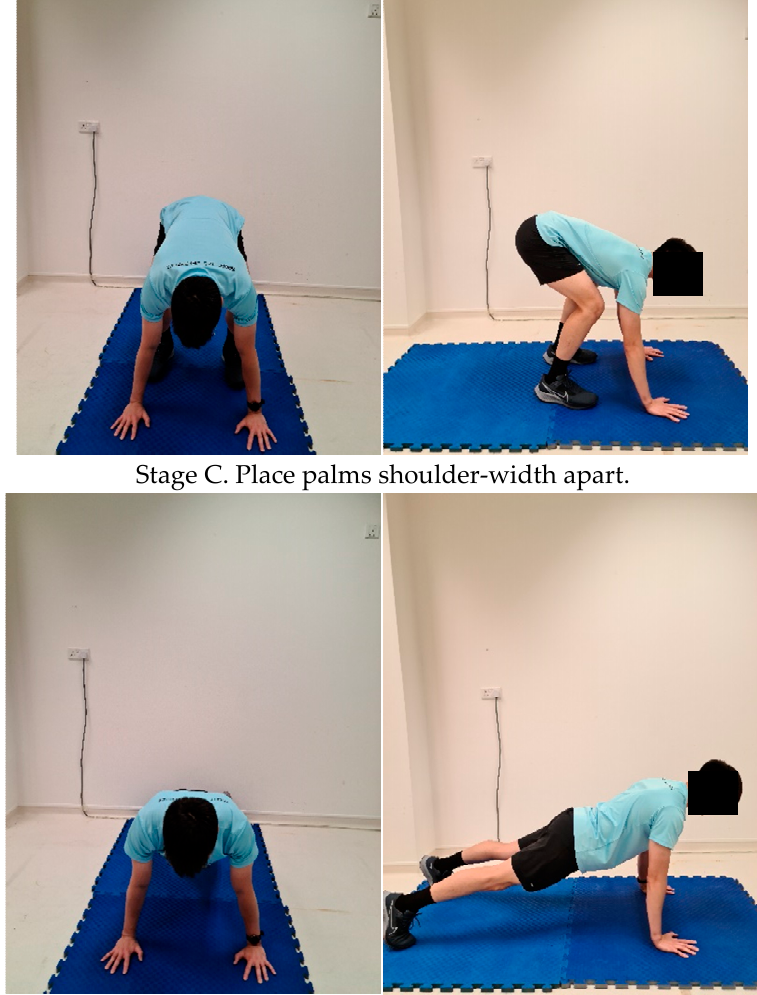
Stage D. Legs thrust backwards fully with no knee bend. Arms fully extended with no elbow bend. Back is not excessively arched or